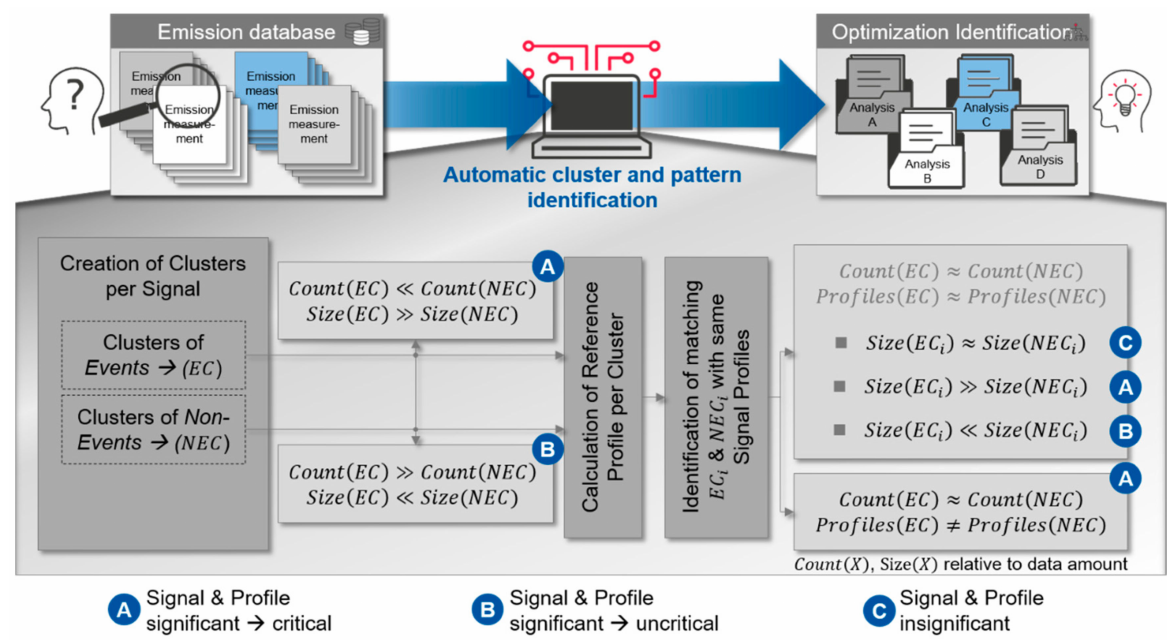
Figure 6. Automated analysis of database measurements for support of calibration